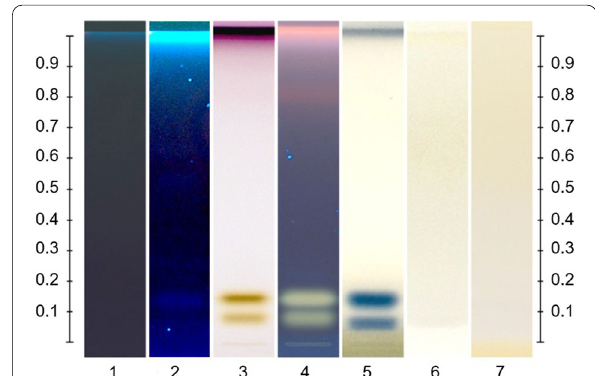
Fig. 2 High‑performance Thin Layer Chromatography (HPTLC) of whole apple ( Malus domestica cv. Anna) freeze‑dried AE powder (1 mg mL − 1 ) (Image Comparison View, CAMAG). The HPTLCs were developed with UV light at 366 nm (1); or derivatized and developed with the natural products reagent and at 366 nm (2); with anisaldehyde at visible light (3); with anisaldehyde at 366 nm (4); with phosphomolybdic acid at visible light (5), with Fast Blue B Salt staining at visible light (6); and with Dragendorff reagent at visible light (7)